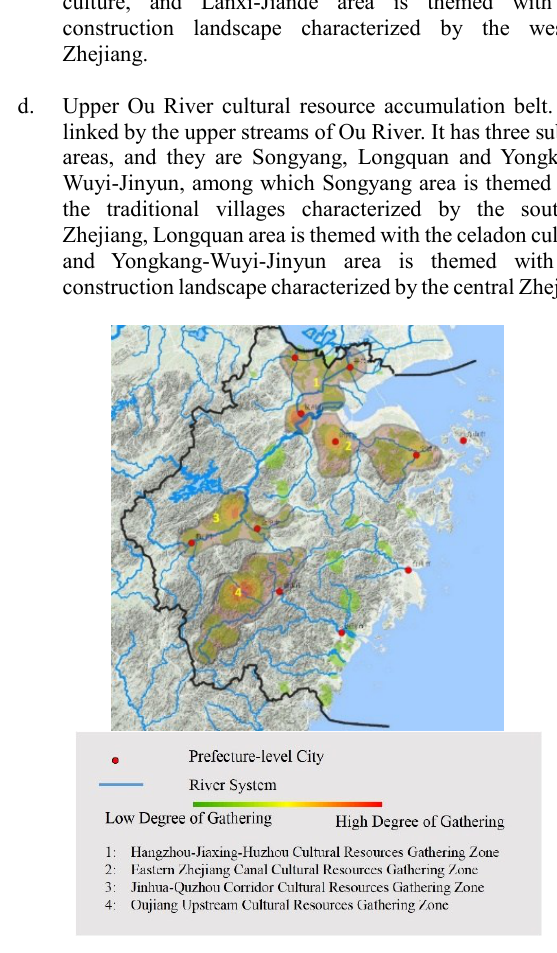
Figure 6. Gathering Map of Culture Resources Density and Districts in Four Zones